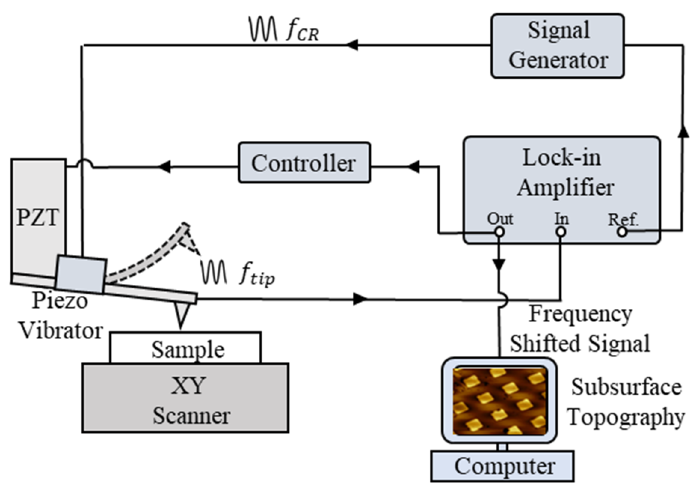
Figure 1. Schematic of the CR-AFM for measuring subsurface